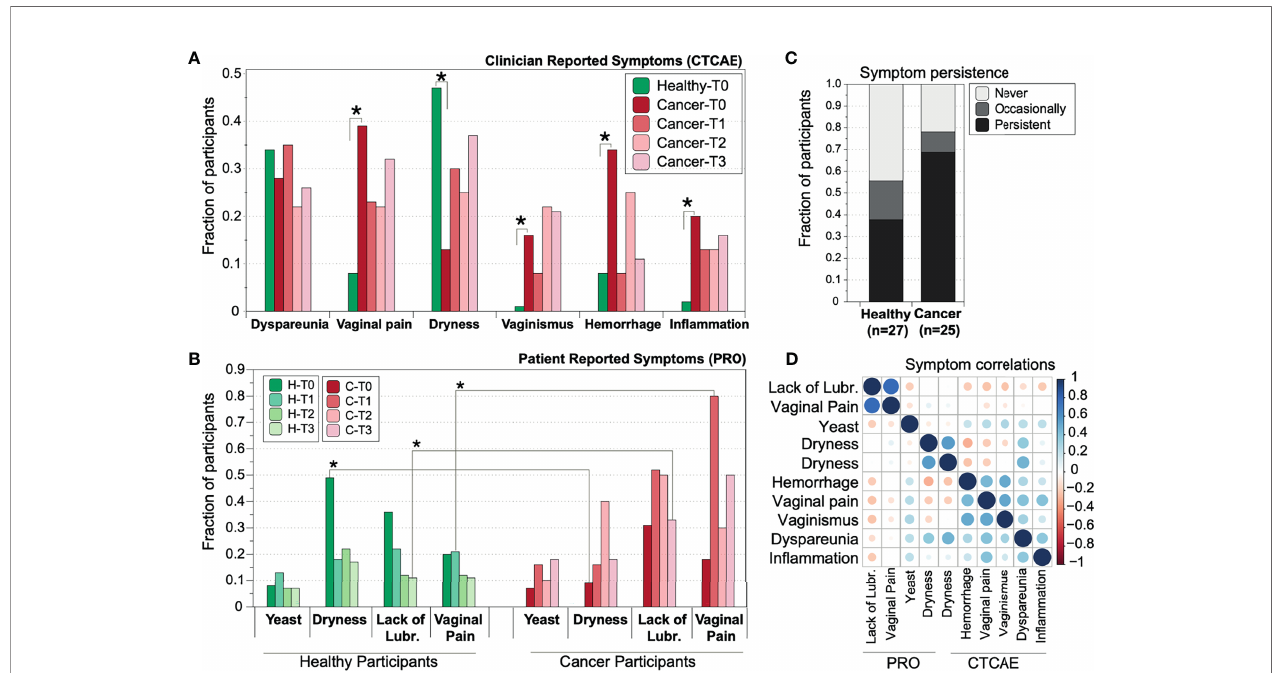
FIGURE 1 | Prevalence of reported vaginal symptoms among gynecologic cancer and healthy postmenopausal women at the different time points of the study. (A) Prevalence of clinician-reported toxicities (B) Prevalence of patient-reported outcomes (PROs)/symptoms. T0=baseline (n=134); T1 = 2.5-3mos after completion of radiation therapy (n=52), T2 = 6mos (n=52), T3 = 12mos post baseline (n=52). Star symbols indicate statistical signi fi cance (p=<0.01, z-test with correction for multiple testing) of the different proportion between gynecologic cancer and healthy cohort. (C) Vaginal symptoms persistence in gynecologic cancer and healthy controls. Percentage of healthy and cancer participants which reported at least one of the four patient reported symptoms: Never, Occasionally (once or twice in the year), Persistently (three or four out of four times). (D) Correlation of PRO symptoms. The correlations were tested after transforming all data to categorical variables (presence or absence of